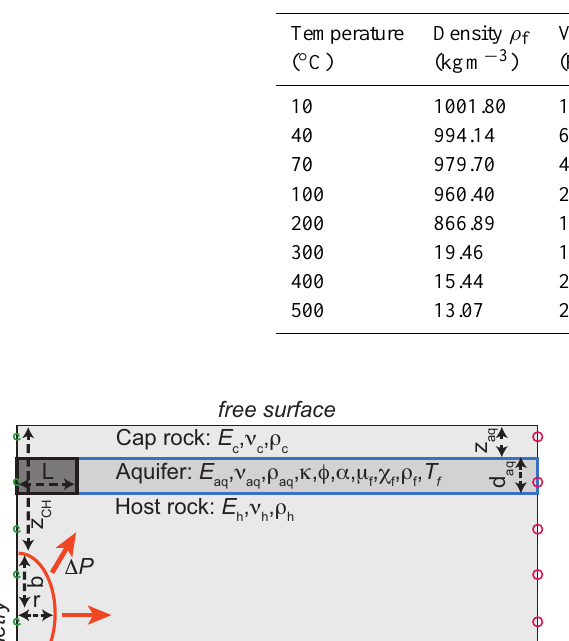
Table 3. Temperature dependent water properties for a pressure of 4.5MPa (calculated using Verma, 2003).